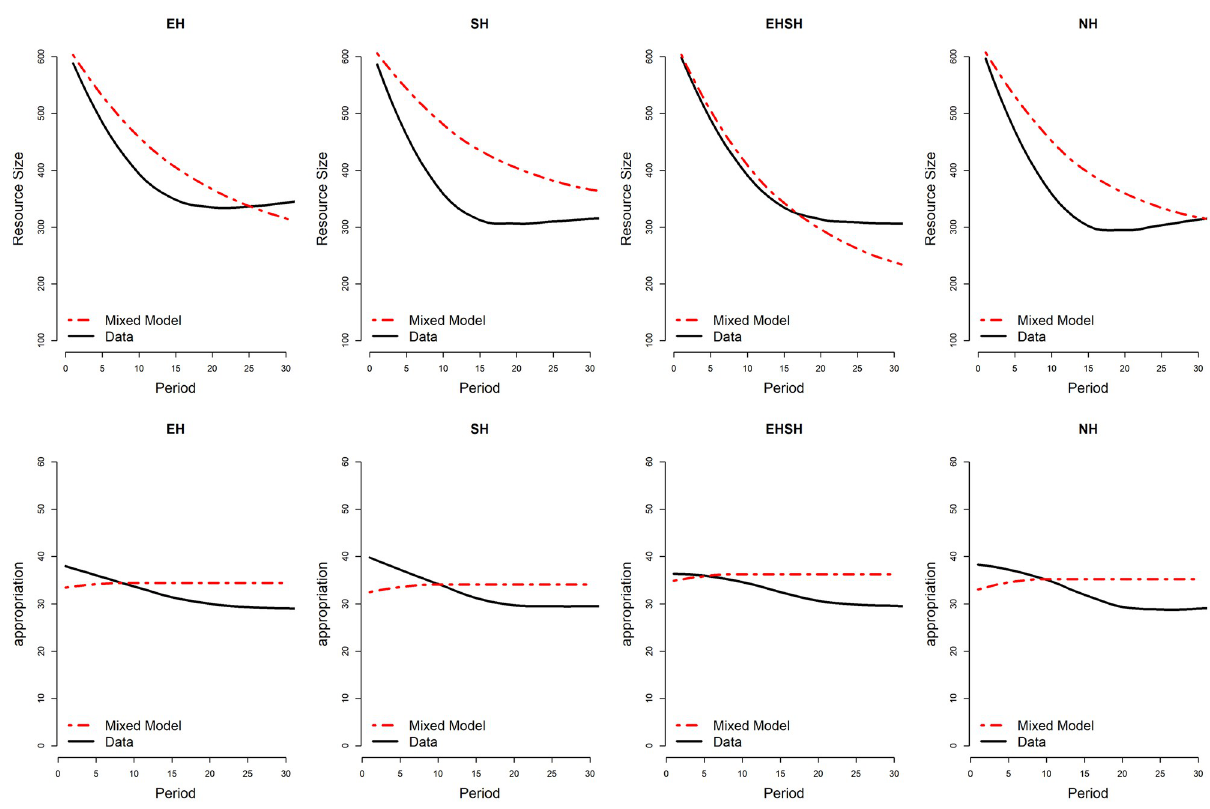
Fig 10. UKNL mixed model predictions for Resource Size (top row) and Appropriation Effort (bottom